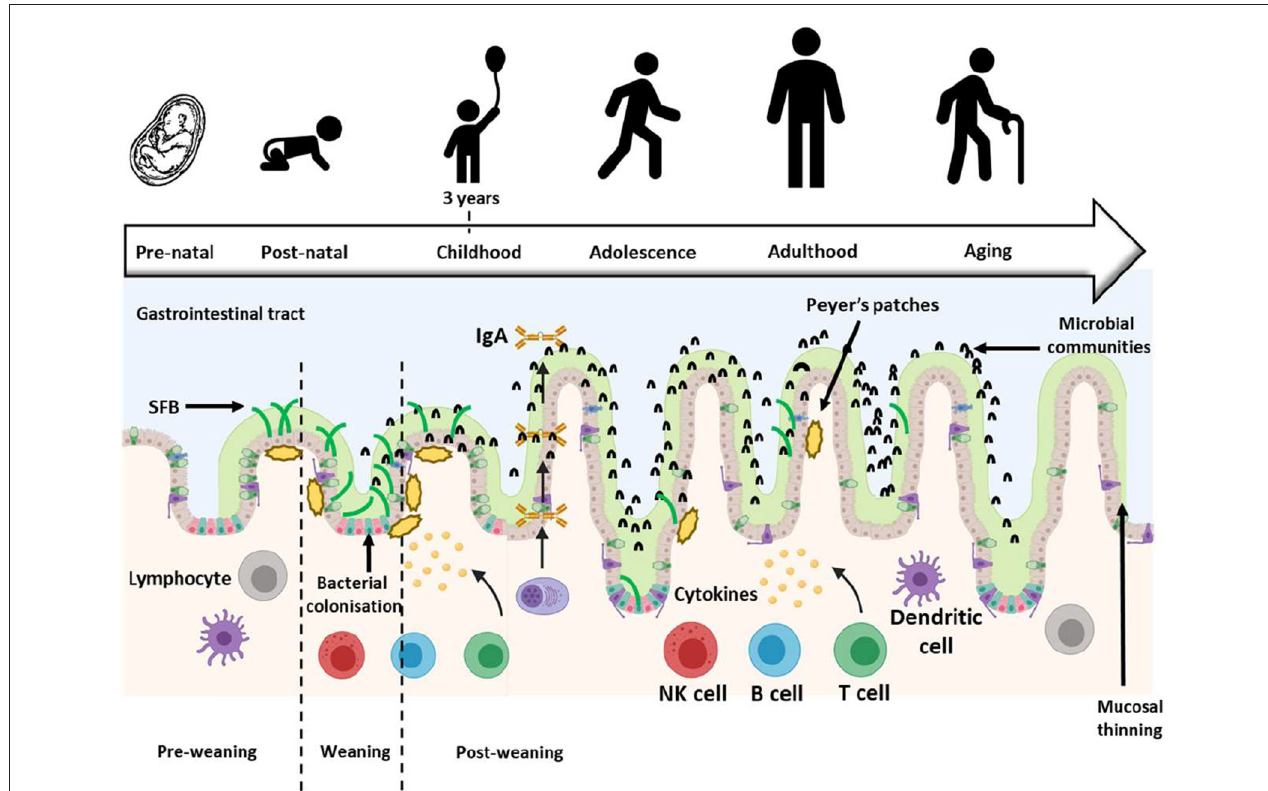
FIGURE 1 | Development of the gastrointestinal tract (GIT) throughout life. The GIT barriers continue developing and maturing postnatally until about 3 years of age when the resident microbiota resembles that of an adult. During this time, SFB abundance changes, first increasing and then decreasing at weaning, but SFB abundance remains low into adulthood [Figure adapted from Jašarevi ´ c et al. (35); Created with BioRender.com and PowerPoint]. SFB, Segmented filamentous bacteria; IgA, Immunoglobulin